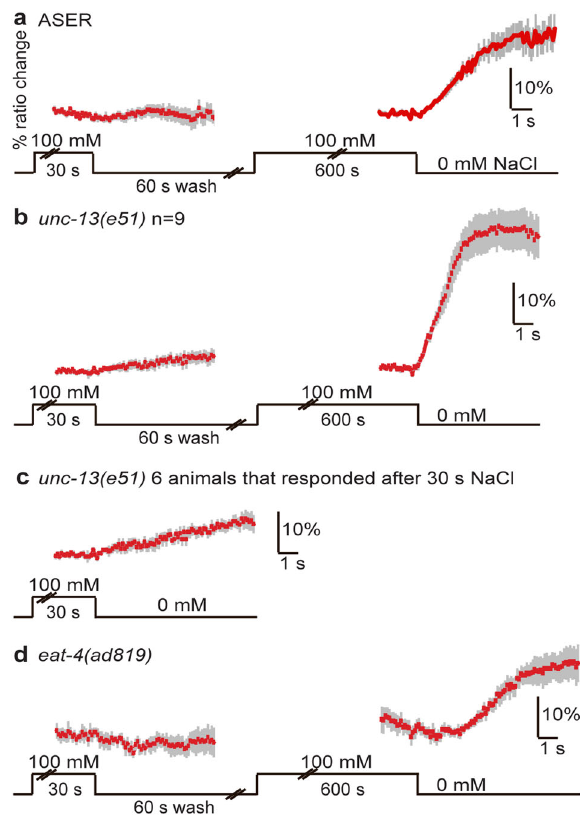
Fig. 5 ASER sensitization is affected by unc-13 and eat-4 mutations. a Average Ca 2 + transient (±SEM) in ASER in wild-type animals in response to a decrease in NaCl concentration from 100 mM to 0 mM after 30 and 600 s exposure ( n = 8 animals). b Average Ca 2 + transients (SEM) in ASER of unc-13(e51) animals ( n = 9) in response to a decrease in NaCl concentration from 100 mM to 0 mM after 30 and 600 s exposure. Thirty seconds of exposure to 100 mM NaCl resulted in a small response in ASER, in six out of nine animals tested. Longer exposure to NaCl resulted in a strong Ca 2 + response of the ASER neurons of unc-13 animals. c Average Ca 2 + transients (±SEM) in ASER of the six unc-13(e51) animals that responded to a decrease in NaCl concentration from 100 mM to 0 mM after 30 s exposure. d Average Ca 2 + transients (±SEM) in ASER of eat- 4(ad819) animals ( n = 5) in response to a decrease in NaCl concentration from 100 mM to 0 mM after 30 or 600 s exposure. Thirty seconds of exposure to 100 mM NaCl did not result in a response. Ten minutes of exposure to 100 mM NaCl did result in a response, albeit 2 s later than in wild-type animals. Source data underlying this fi gure are available in Supplementary Data